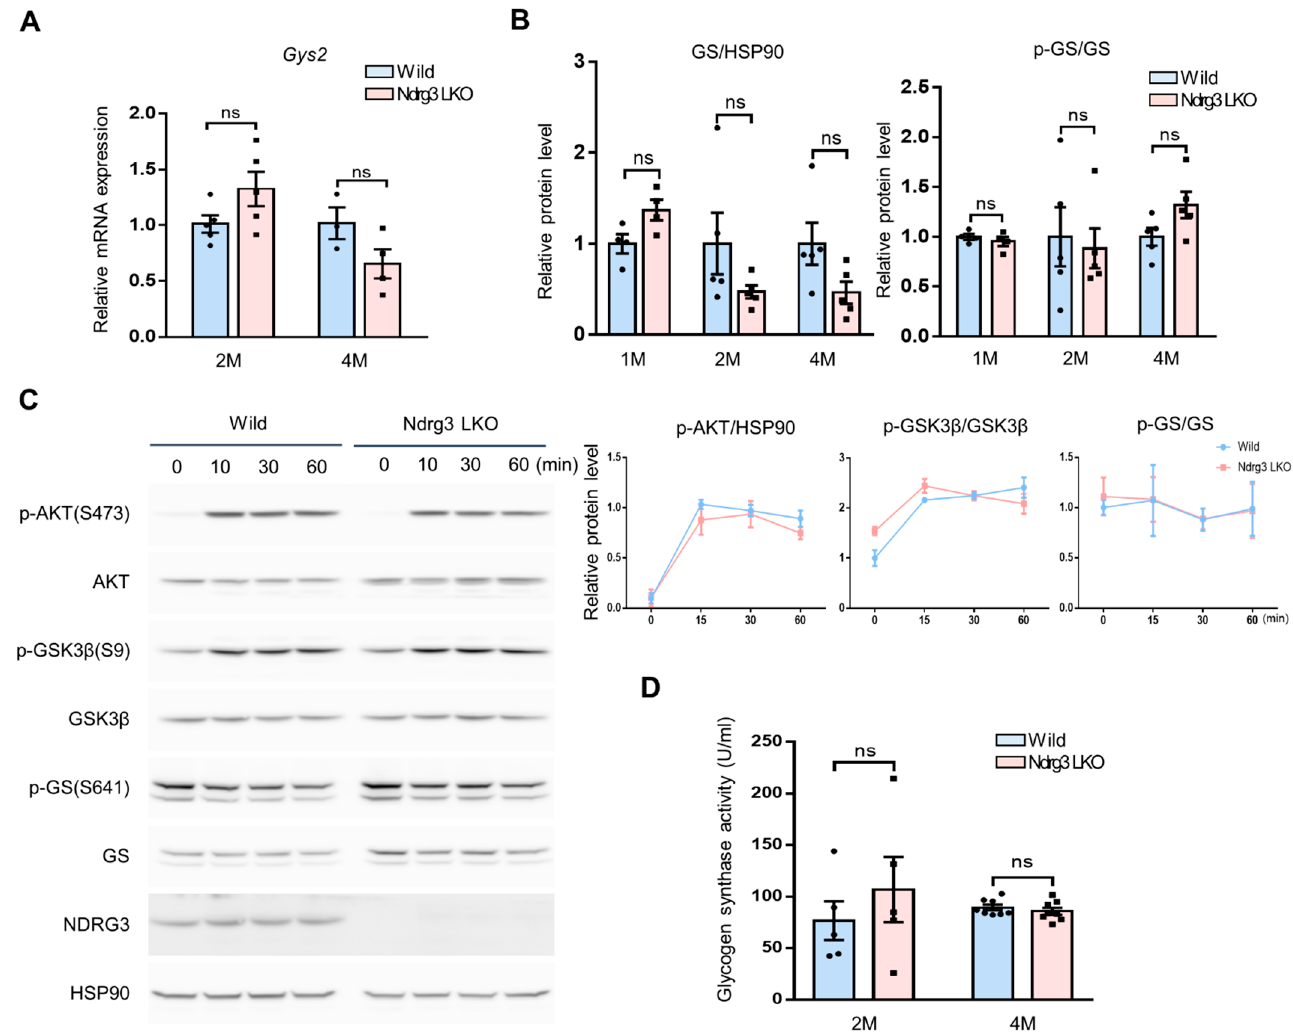
Figure 3. Intact glycogen biosynthesis capacity in Ndrg3 LKO mice. ( A ) qRT-PCR analysis of Gys2 gene expression in overnight-fasted wild-type and Ndrg3 LKO mouse livers at 2 or 4 months of age ( n = 3–4 per group). Gene expression was normalized using Gapdh as the reference. ( B ) Expression of glycogen synthase (GS) protein in wild-type and Ndrg3 LKO mouse livers at increasing ages ( n = 4–5 per group). Total GS and p-GS(S641) were quantified from immunoblots shown in Figure S3B using ImageJ program. The levels of p-GS(S641) relative to total GS (p-GS/GS) are shown on the right. ( C ) Time-dependent analysis of insulin signaling in primary hepatocytes obtained from 2-month-old wild-type and Ndrg3 LKO mice. Insulin signaling was assessed by Western blotting using p-AKT(S473), p-GSK3 β (S9), and p-GS(S641) as the markers. ( D ) GS activity in the livers of 2-month-old wild-type and Ndrg3 LKO mice ( n = 5 per